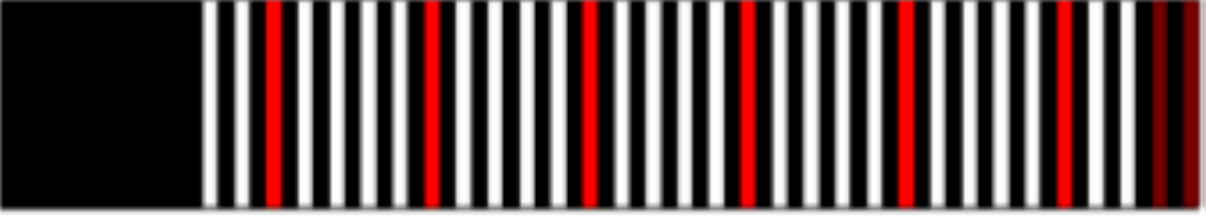
Figure 5. Finite element simulated microtubule (MT) structure. Black layers represent α -tubulin monomers ( n Low = 1.07402), white, red, and brown layers are β -tubulin monomers with n High = 7.3, n d 1 = 3.3, and n d 2 = 2 respectively.